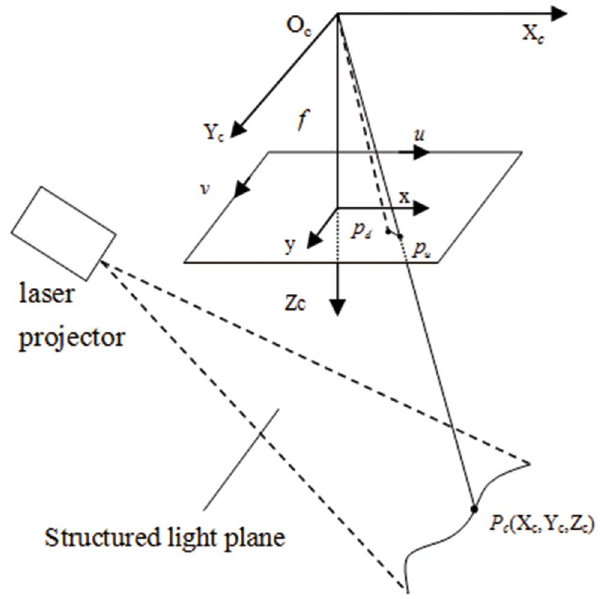
Figure 1. Overview of the structured light vision system.